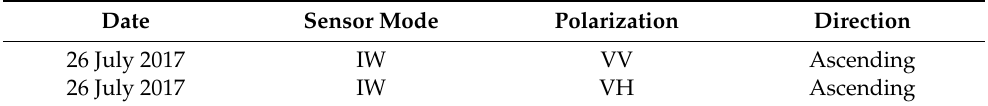
Table 2. Sentinel-1A data information.